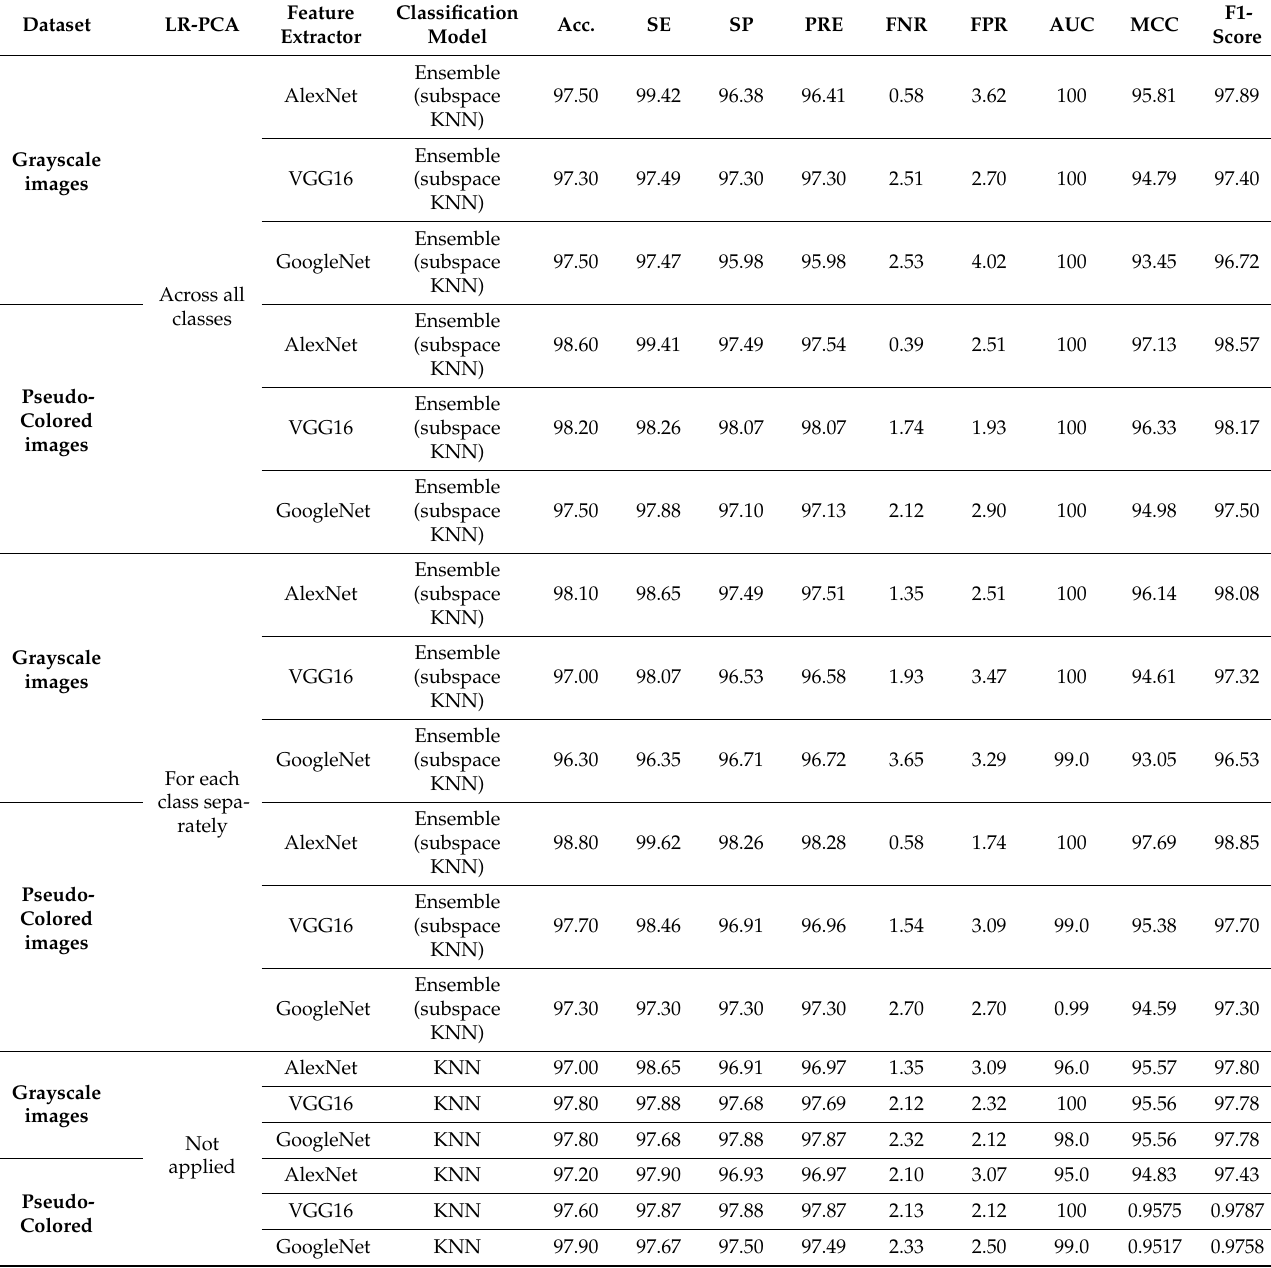
Table 3. Classification evaluation performance (%) of the proposed CAD system with three different backbone deep learning classifiers. These results were derived using mini-MIAS